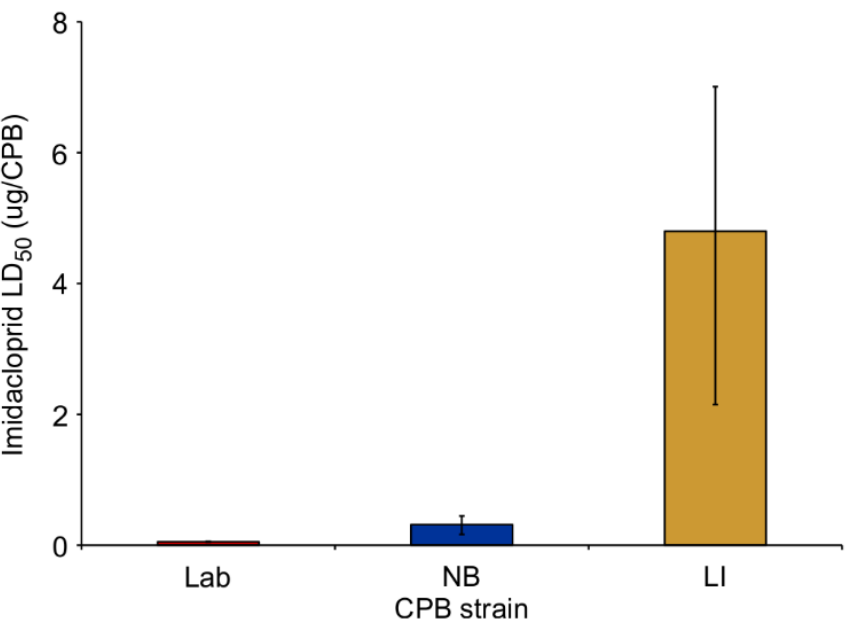
Figure 1. The estimated median lethal dose (LD 50 ) of imidacloprid ( ± fiducial limits) for three Colorado potato beetle strains: laboratory insecticide-susceptible (Lab); New Brunswick field-collected strain (NB) and multi-resistant insecticide strain collected from Long Island, NY (LI) data from Scott et al. 2015 [4]).